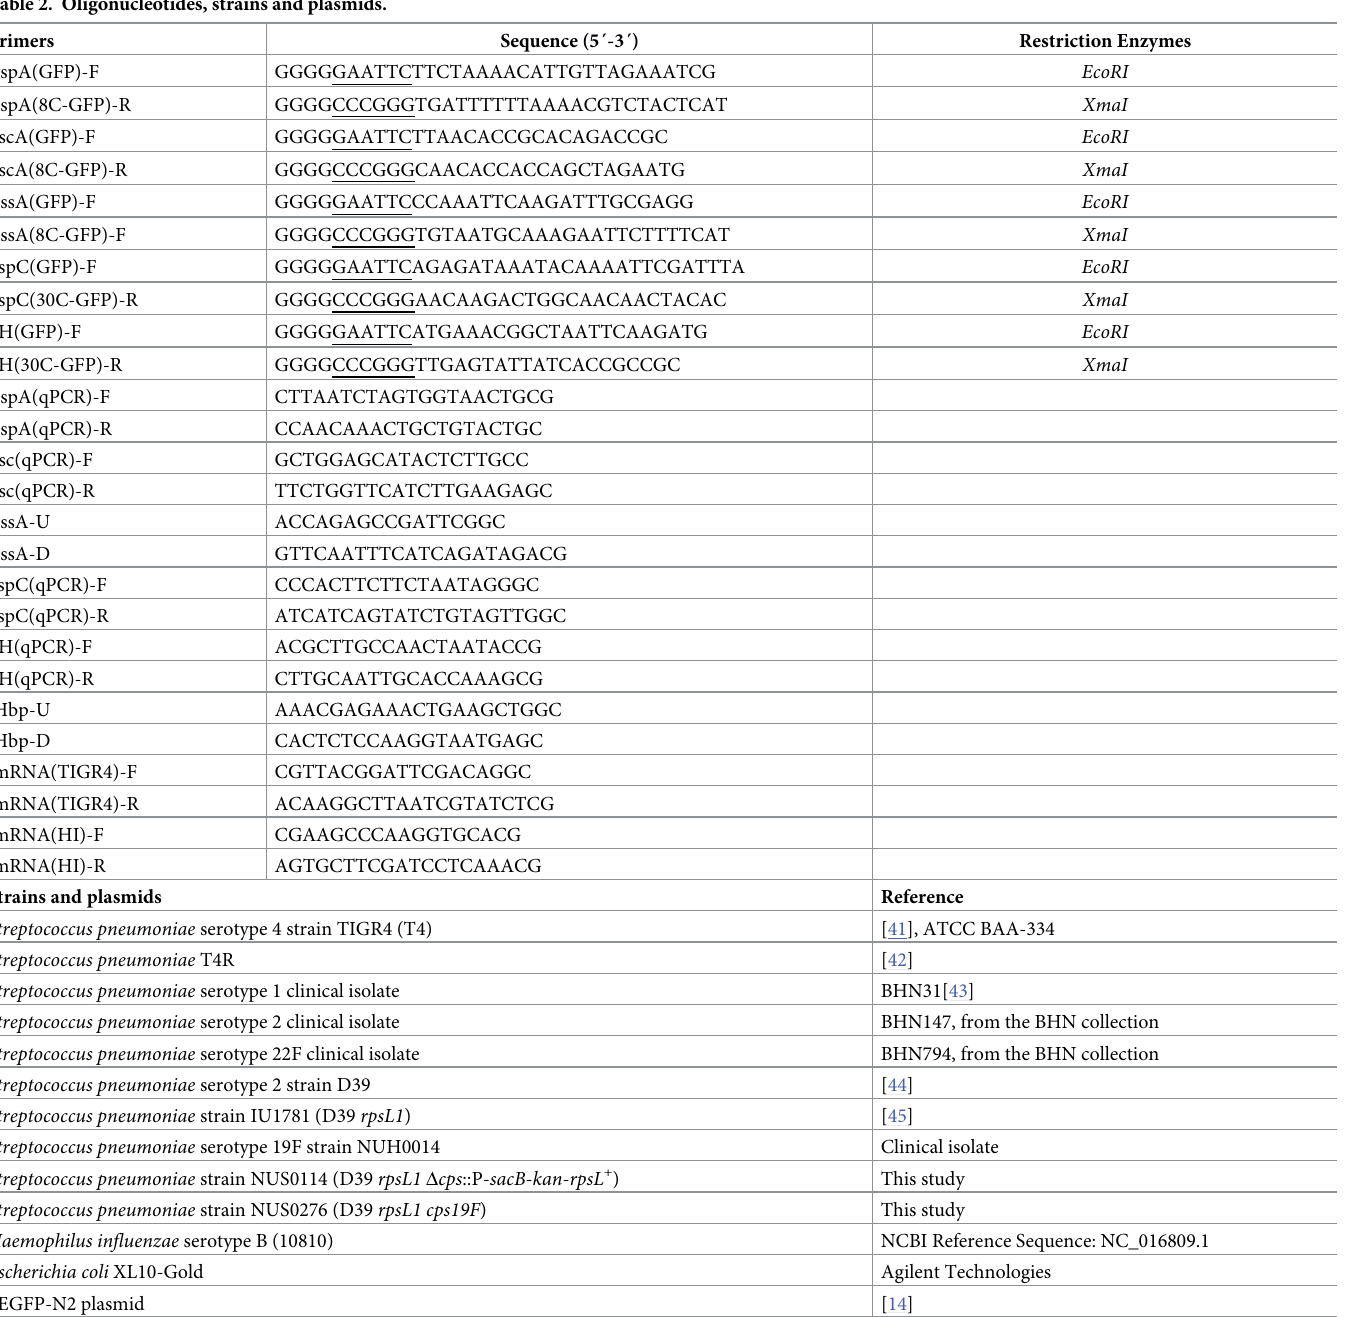
Table 2. Oligonucleotides, strains and